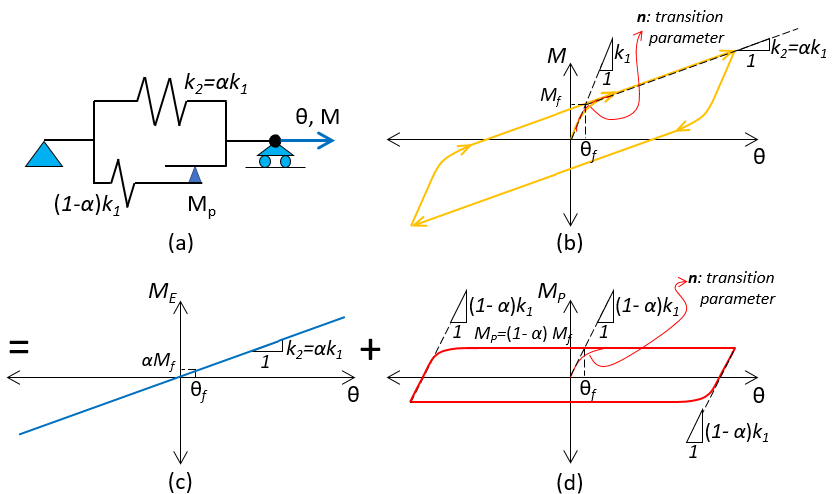
Figure 5. ( a ) Bouc – Wen bilinear conceptual model. ( b ) Hysteretic characteristic curve of the model, ( c ) linear elastic component of the model, ( d ) plastic component of the